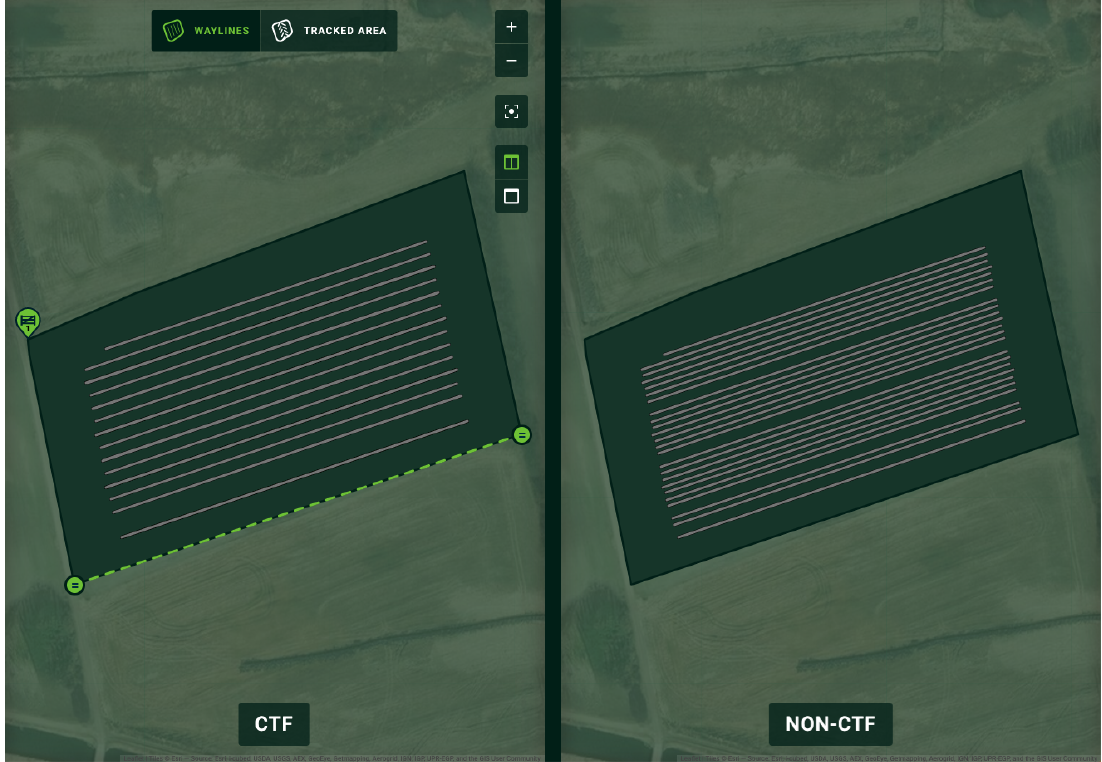
Figure 3. Controlled traffic farming: Combined set of all waylines across the three